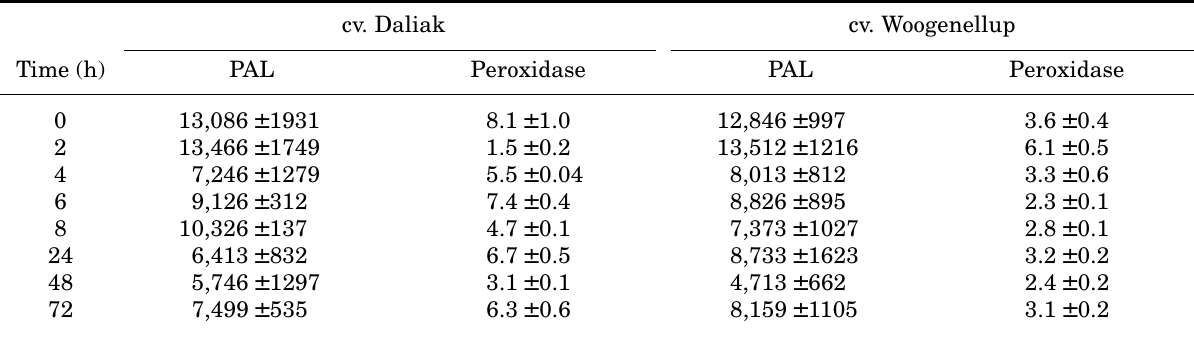
Table 2. Activities of phenylalanine ammonia-lyase (PAL) (nmol cinnamic acid produced h -1 g -1 f wt) and peroxidase ( D OD s -1 g -1 f wt) in leaves of control plants of subterranean clover cultivars Daliak and Woogenellup (mean – standard error, n =